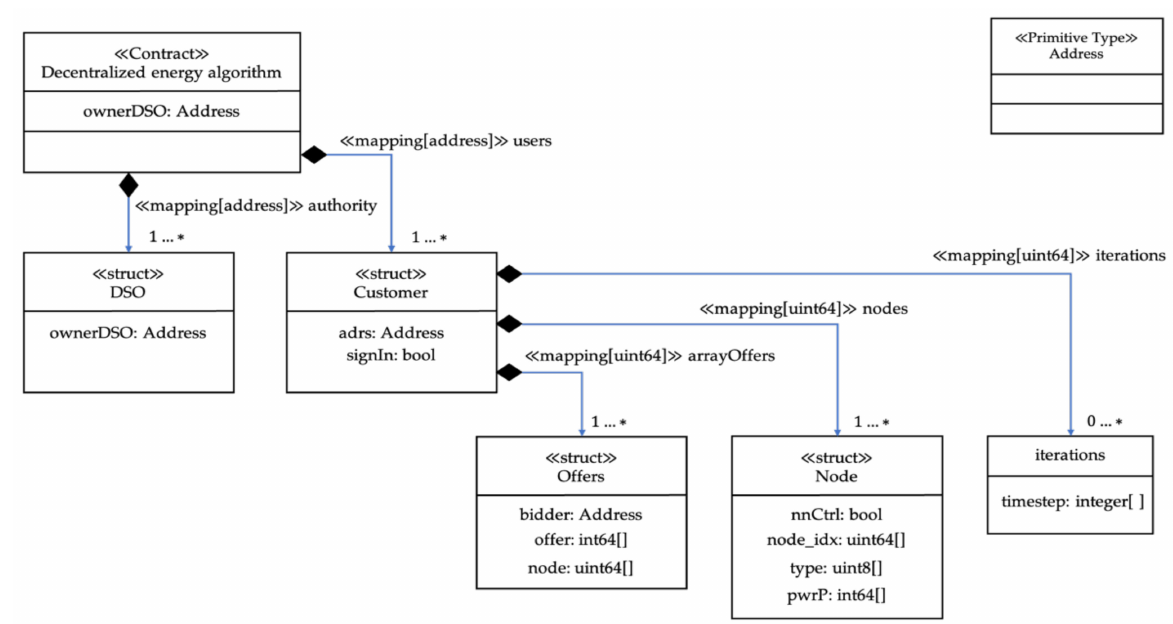
Figure 3. Contract diagram of the implemented SC.